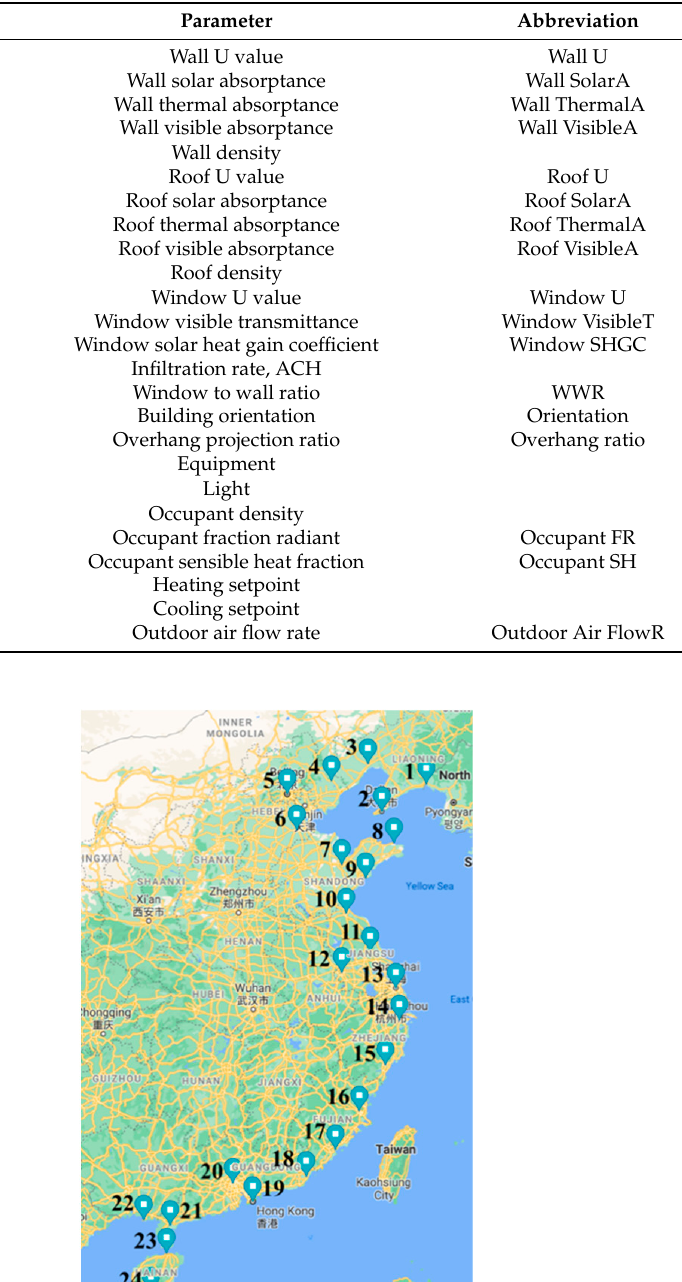
Table 3. Input parameters for SA.